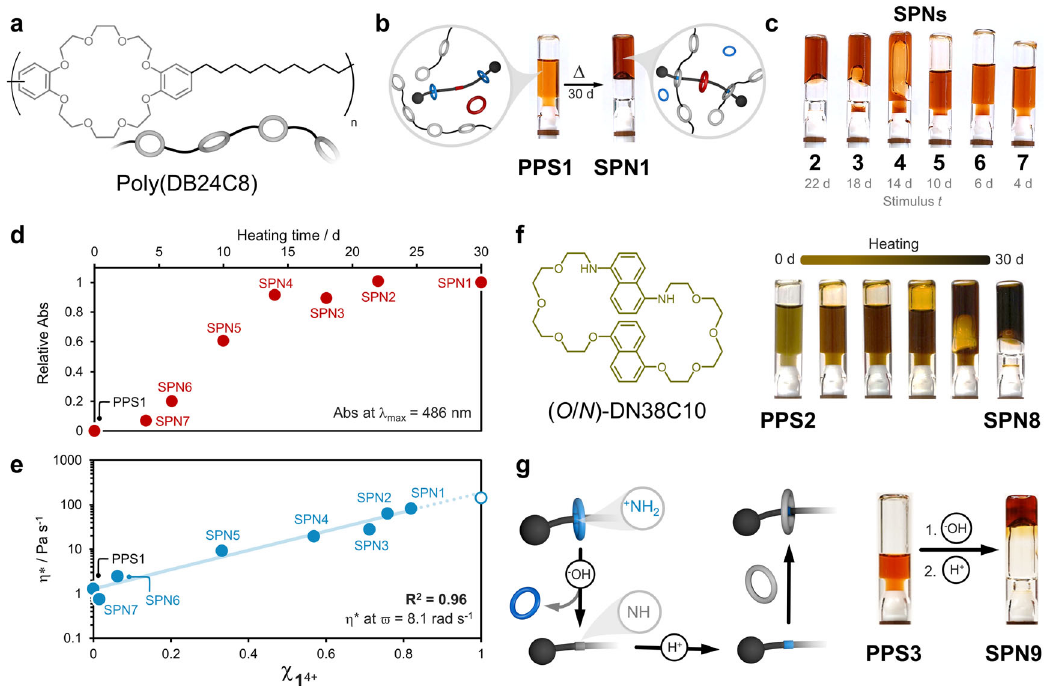
Fig. 4 Supramolecular gels formed from the controlled dissociation of a metastable rotaxane. a Chemical structure and cartoon of polymer poly(DB24C8) 22 . b Thermally controlled disassembly of the preprogrammed system PPS1 and its assembly into SPN1 . c SPNs 2 – 7 , all prepared in (CHCl 3 / CH 3 CN, 1/1, v/v) and heated (70 °C) for an arbitrary period (see Supplementary Methods); [[3] MSR ] = 1.3 × 10 − 2 M, [DN38C10] = 1.3 × 10 − 2 M, and [poly(DB24C8)] = 3.1 × 10 − 1 M. Photographs were taken upon equilibration at room temperature. d Relative absorbance changes for the CT band (486 nm) throughout the heating progress; all samples were diluted to 5 × 10 − 3 M (CHCl 3 /CH 3 CN, 1/1, v/v) prior to collecting the corresponding spectrum. e Complex viscosity ( η *) changes over the thermal treatment of a preprogrammed system (measured at 15 °C). Fitting to a logarithmic function is shown as a blue line. The open symbol represents a reference sample prepared with [ 1 [PF 6 ] 4 ] = 1.3 × 10 − 2 M, [DN38C10] = 1.3 × 10 − 2 M, [ 22C6 ] = 2.6 × 10 − 2 M, and [poly(DB24C8)] = 3.1 × 10 − 1 M. f Alternative approach to tune the apparent color of preprogrammed SPNs. PPS2 prepared in CHCl 3 /CH 3 CN, 1/1, v/v, its evolution was imaged at different stages (six shown) after equilibrating to room temperature; [[3] MSR ] = 1.3 × 10 − 2 M, [(O/ N)-DN38C10] = 1.3 × 10 − 2 M, and [poly(DB24C8)] = 3.1 × 10 − 1 M. g Acid/base controlled self-assembly of PPS3 ; [[3] MSR ] = 2.0 × 10 − 2 M, [DN38C10] = 2.0 × 10 − 2 M, and [poly(DB24C8)] = 3.0 × 10 − 1 M in CHCl 3 /CH 3 CN, 1/1, v/v. The schematic shows the expected transformation at the acid/base-responsive station (DBA) in 1 4 + . Scale bars represent 1